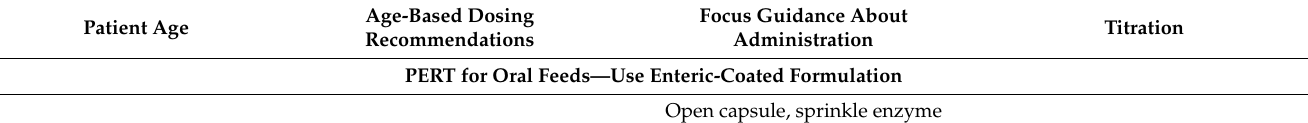
Table 2. PERT Dosing